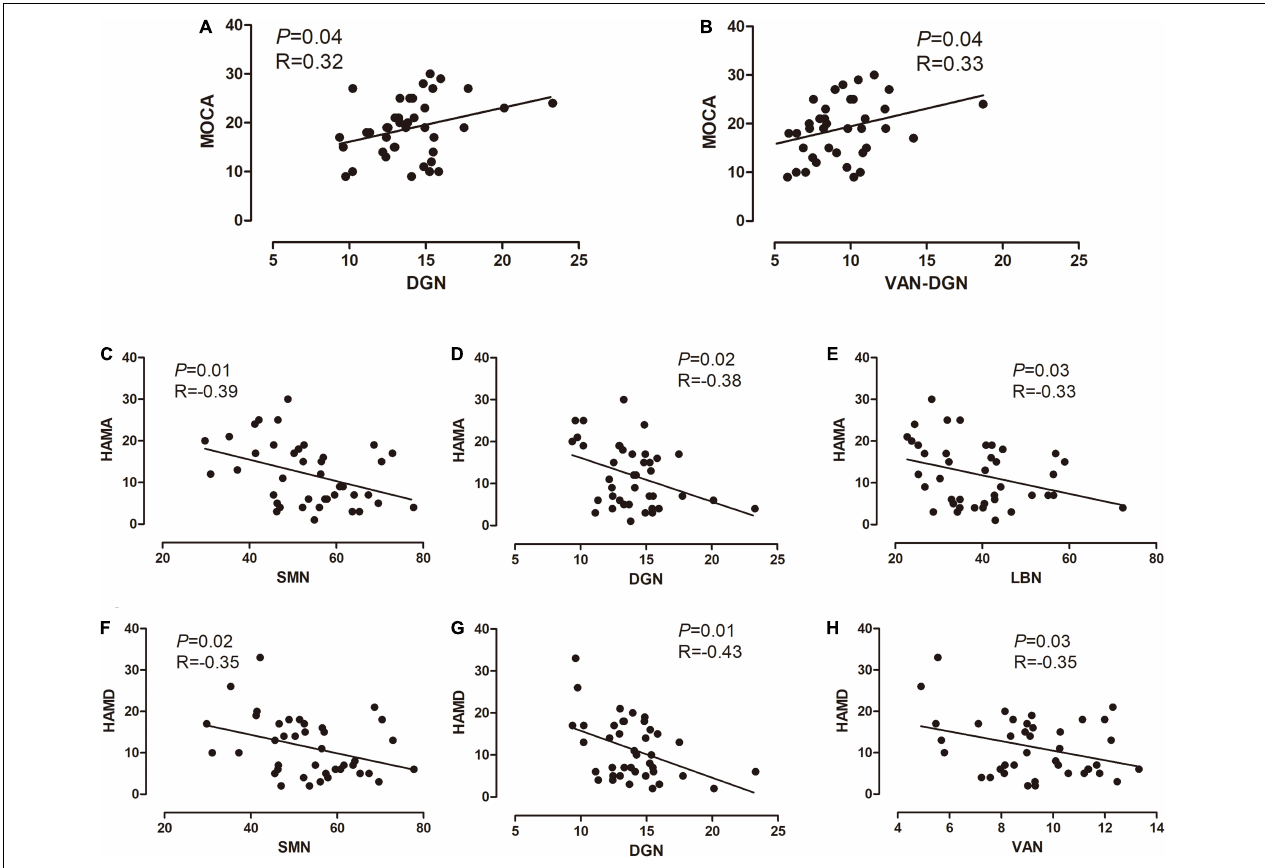
FIGURE 4 | Correlations between altered connectivity and clinical information. (A,B) Correlations between the MoCA scores, intra-network connections of the DGN, and inter-network connections between the VAN and DGN, in the PD group. (C–E) Significant correlations between the HAMA scores and intra-network connections of the SMN, LBN, and DGN in the PD group. (F–H) Significant correlations between the HAMD scores, and intra-network connections of the SMN, VAN, and DGN. The x-axis represents the intra- or inter-network functional connectivity strength. PD, Parkinson’s disease; MoCA, Montreal Cognitive Assessment; SMN, somatomotor network; VAN ventral attention network; LBN, limbic network; DGN, deep gray matter network; HAMA, Hamilton Anxiety Scale; HAMD, Hamilton Depression